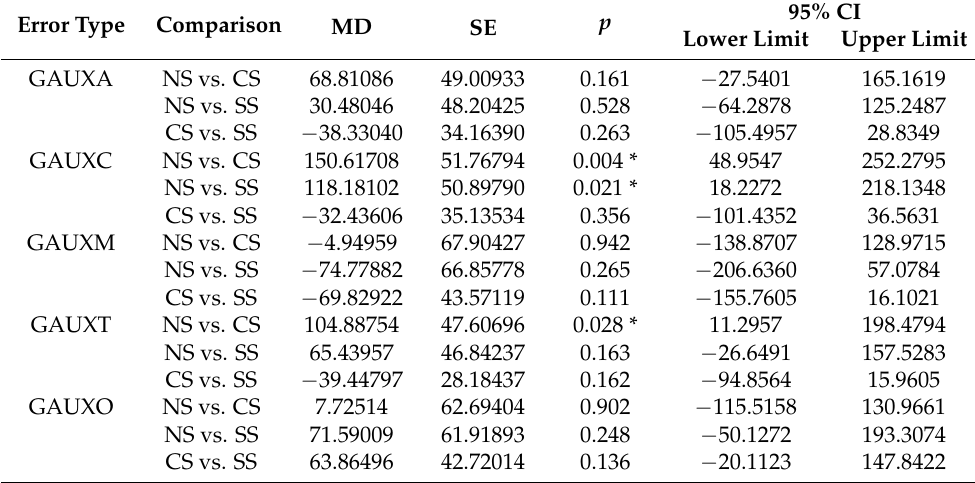
Table 3. Results of the post hoc comparisons according to error types, with the LSD